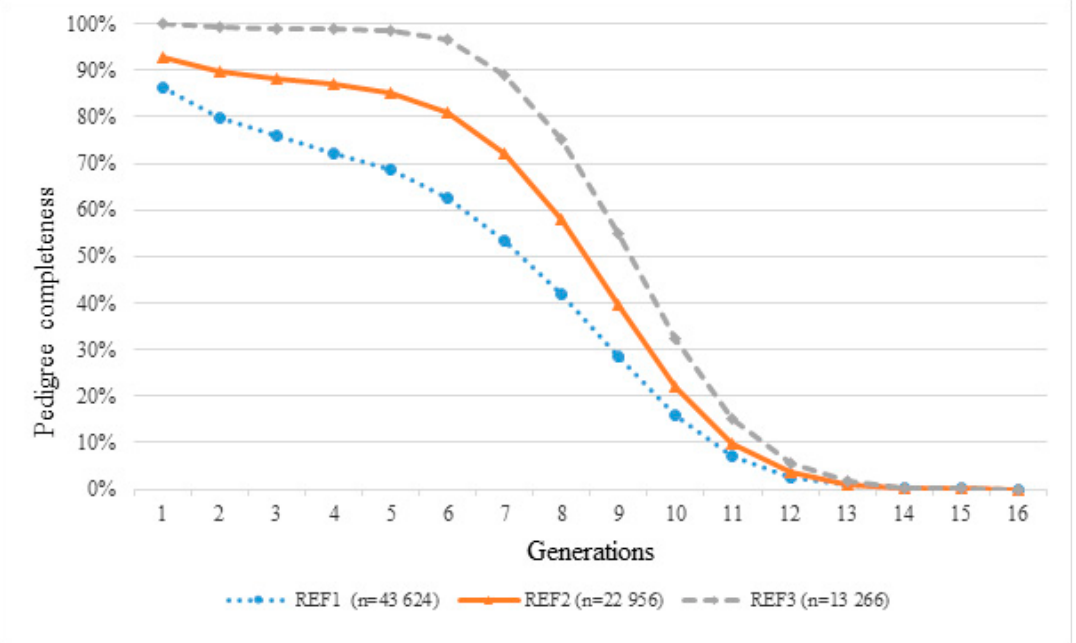
Figure 1. The completeness of pedigree information for the three Sardinian Anglo-Arab (SAA) reference populations.